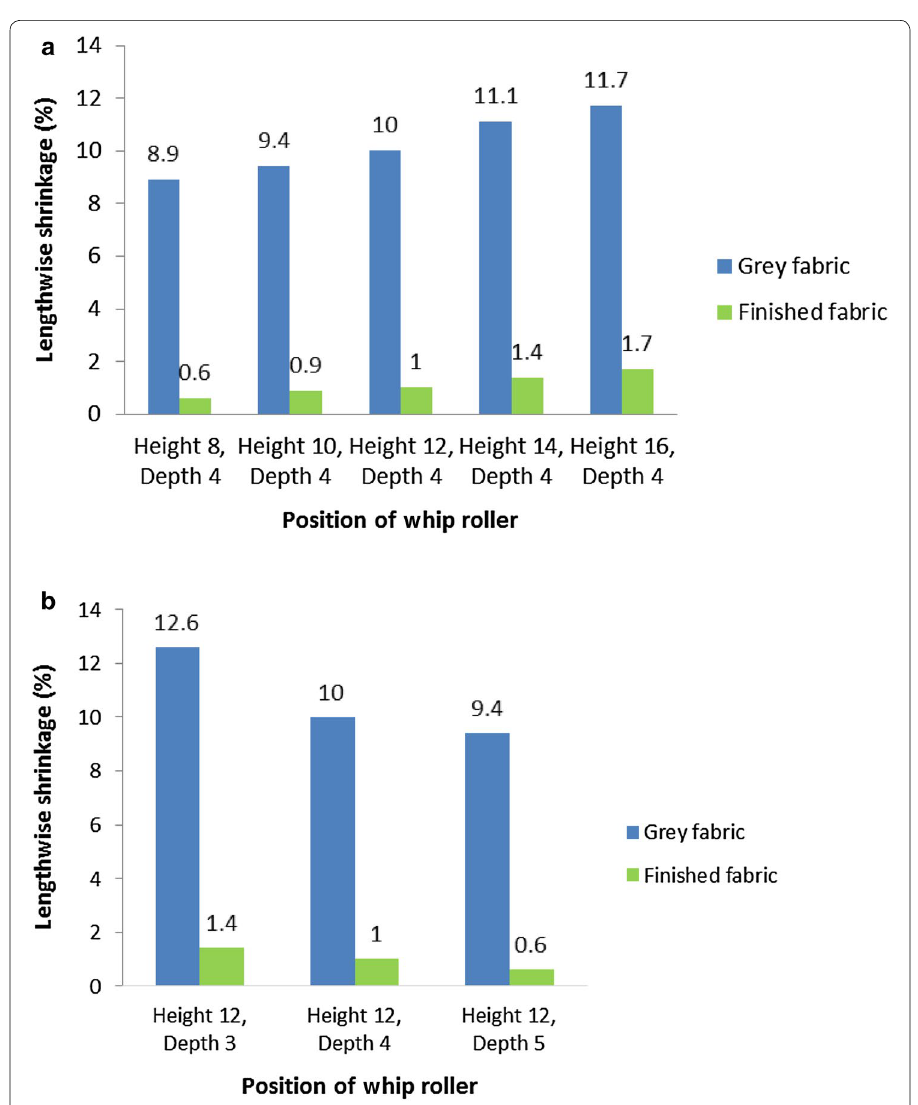
Fig. 11 a Length wise shrinkage (%) at variable height and constant depth of whip roller. b Length wise shrinkage (%) at constant height and variable depth of whip